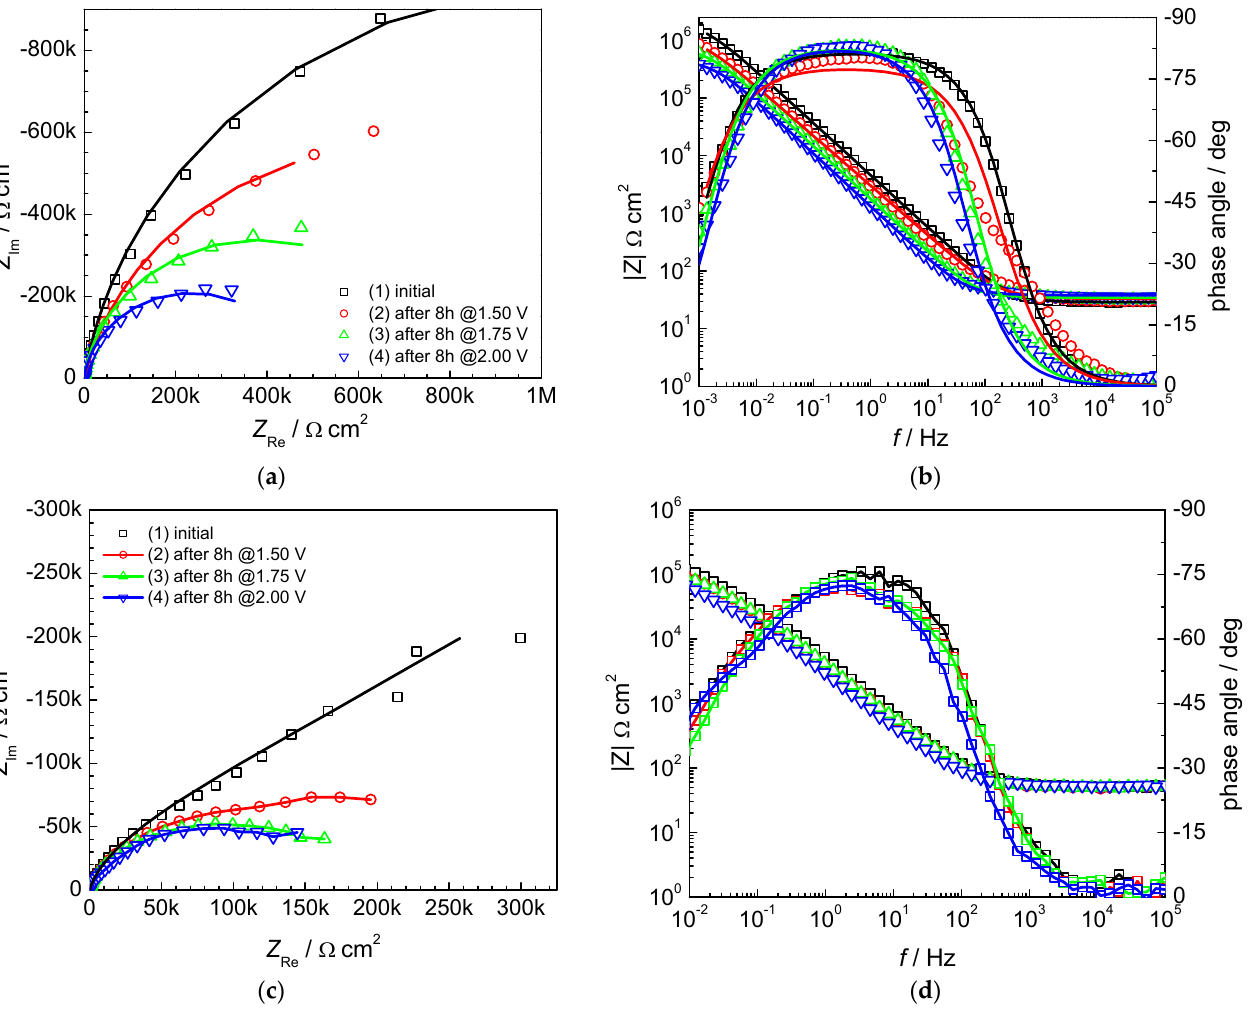
Figure 3. Electrochemical impedance spectra recorded at open circuit potential for the initial state and after PST in 0.1 M Na 2 SO 4 + 0.1 ppm F − 1 (pH = 5): ( a ) Nyquist and ( b ) Bode plots of AISI 442 steel sample; ( c ) Nyquist and ( d ) Bode plots of AISI 446 steel sample. Temperature 25 °C. The Nyquist plots of AISI 442 and AISI 446 in Figure 3a,c point to a single capacitive semicircle with the largest diameter in the initial state and decreasing diameters after the PST. The semicircle diameter corresponds to the polarization resistance R p and is, therefore, a direct indication of the corrosion resistance properties. The surface changes induced by corrosion during PST explain the gradual decrease in the impedance and semicircle diameter observed after the PST. The simultaneous increase in the double-layer capacitance, which is a measure of the active surface area, also supports this conclusion. A